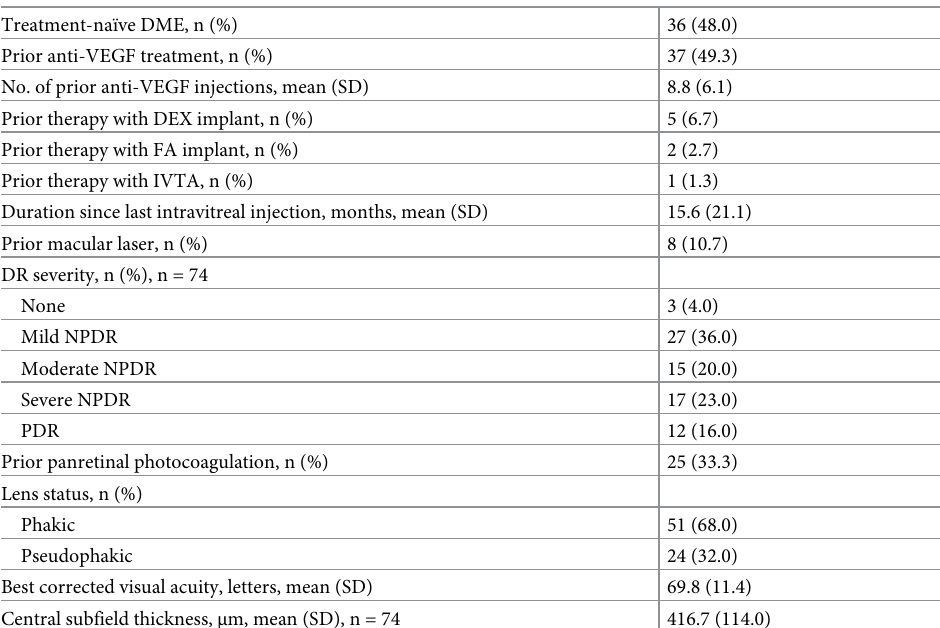
Table 2. Ophthalmological characteristics.